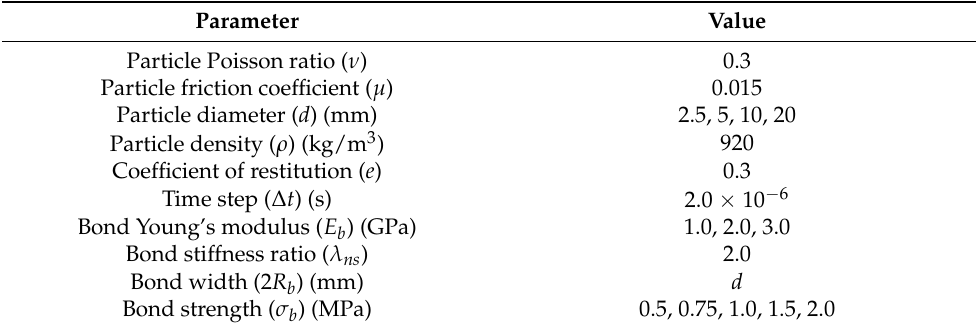
Figure 2. Problem description of numerical simulations: ( a ) three-point bending test; ( b ) uniaxial compressive test. Table 1. Summary of simulation